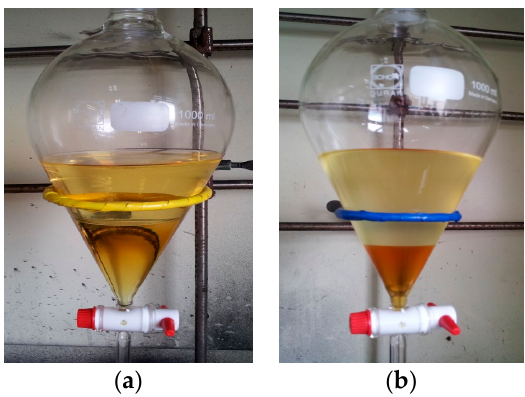
Figure 3. The upper and lower layer obtained from catalyzed transesterification ( a ) VCO, and ( b ) WCO.